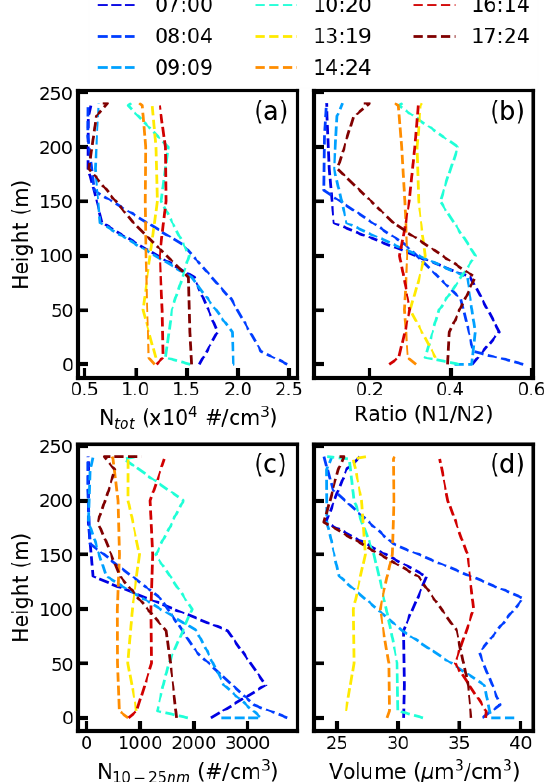
Figure 3. The measured (a) aerosol number concentrations, (b) number ratio of the nucleation-mode aerosol number concen- trations to Aitken-mode aerosol number concentrations, (c) aerosol number concentrations for 10–25nm, and (d) measured aerosol vol- ume concentrations at different altitudes. The filled colors of differ- ent lines denote the different measurement time.